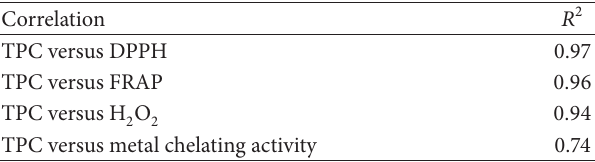
Table 3: Correlation between total phenolic contents (TPC) and antioxidant activities of date extracts.